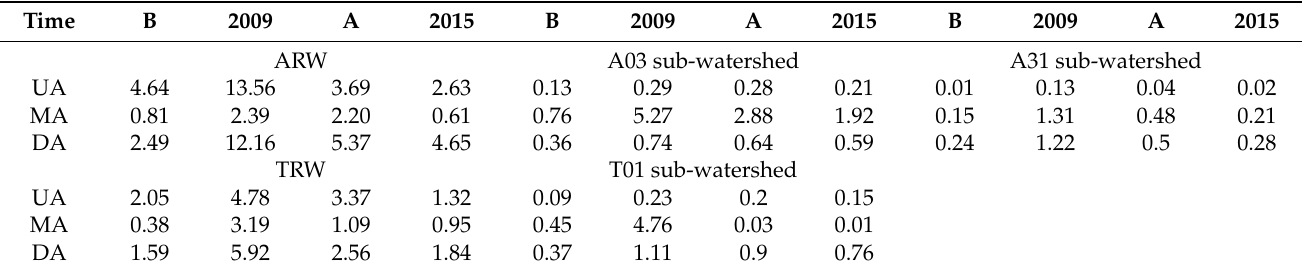
Table 4. The topographic position analysis results in the ARW and TRW .